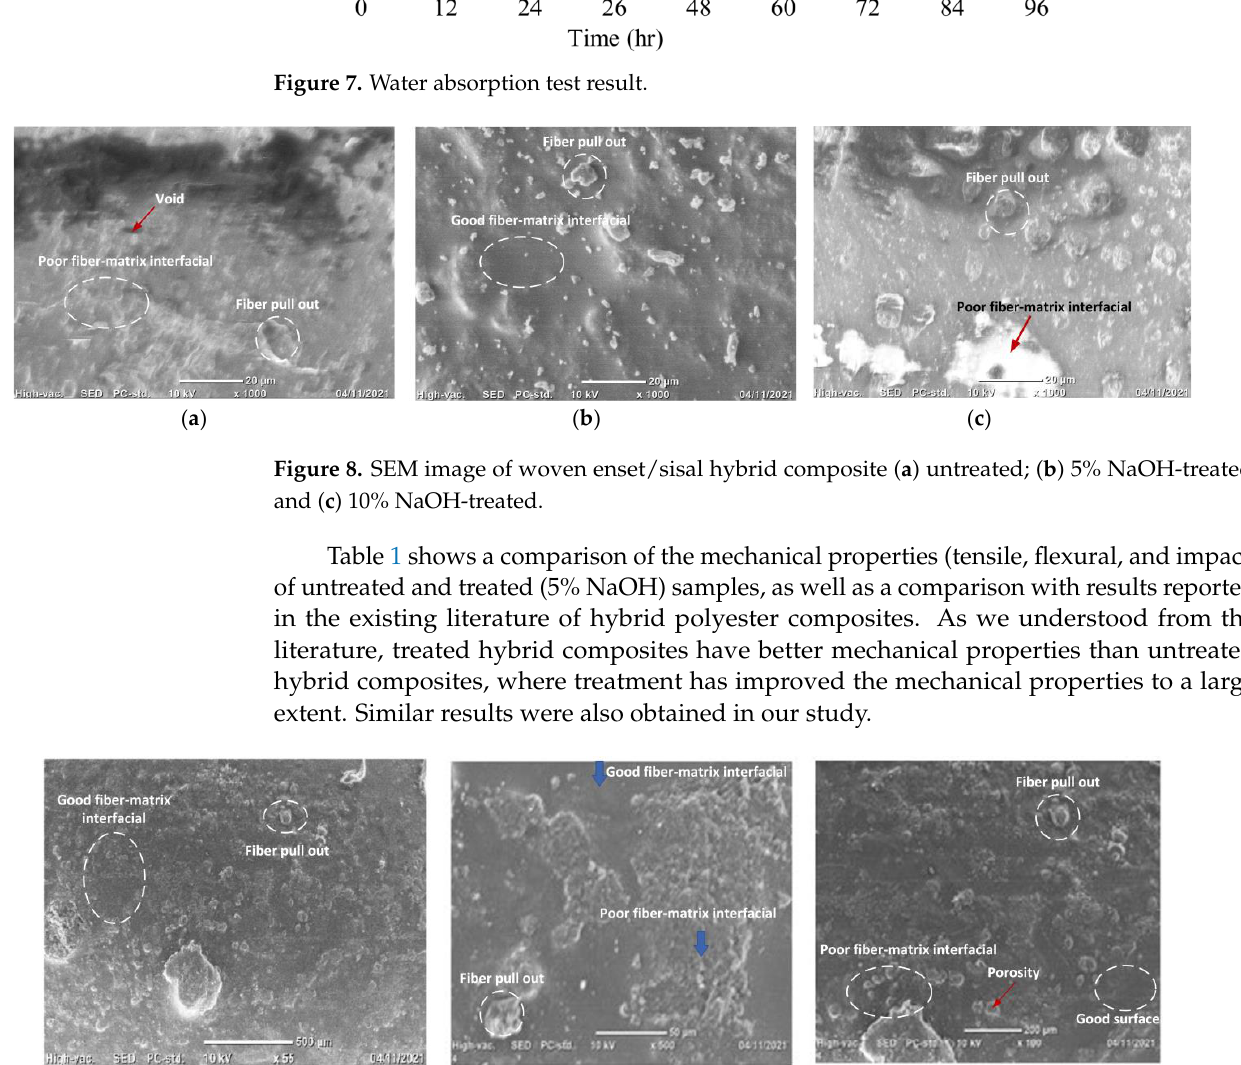
Figure 9. SEM image of unidirectional enset/sisal hybrid composite ( a ) untreated; ( b ) 5% NaOH- treated; and ( c ) 10% NaOH-treated.